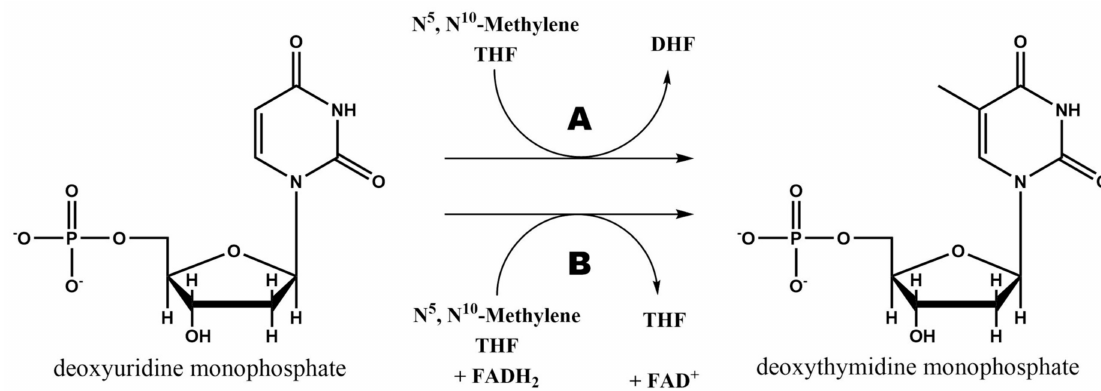
Figure 5. dTMP biosynthesis reaction from deoxyuridine-5 (cid:48) -monophosphate (dUMP) and a THF derivative catalyzed by thymidylate synthase ( A ) and flavin-dependent thymidylate synthase ( B